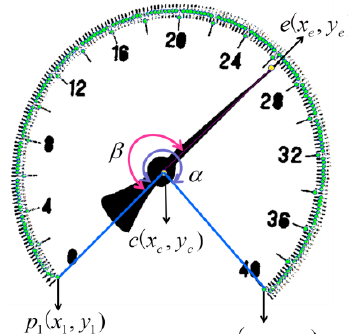
Figure 3. Result of the detected the end point e ( x e , y e ) of pointer, the rotation center c ( x c , y c ) and all the Figure 3. result of the detected the end point , ) midpoints of scales in the pointer meter.